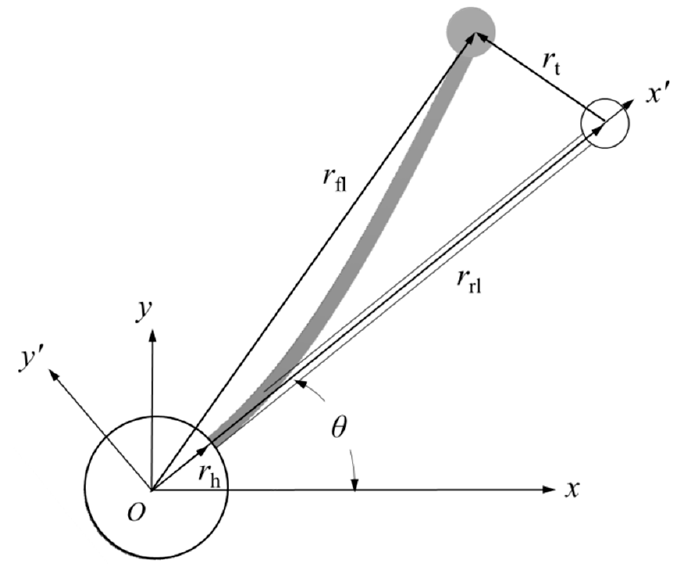
Figure 4. Kinematic modeling of an SFF